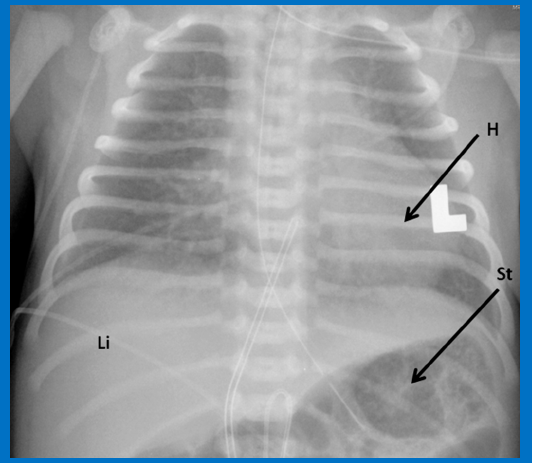
Figure 1. Chest roentgenogram of a baby demonstrating the heart (H) in the left chest (L), i.e., levocardia. This is the usual position of the heart in most patients. The roentgenogram further demonstrates the liver (Li) on the right side of the abdomen and the gaseous opacity of the stomach (St) on the left side, again normal. This is described as situs solitus of the viscera. L indicates left. Reproduced from reference [4].